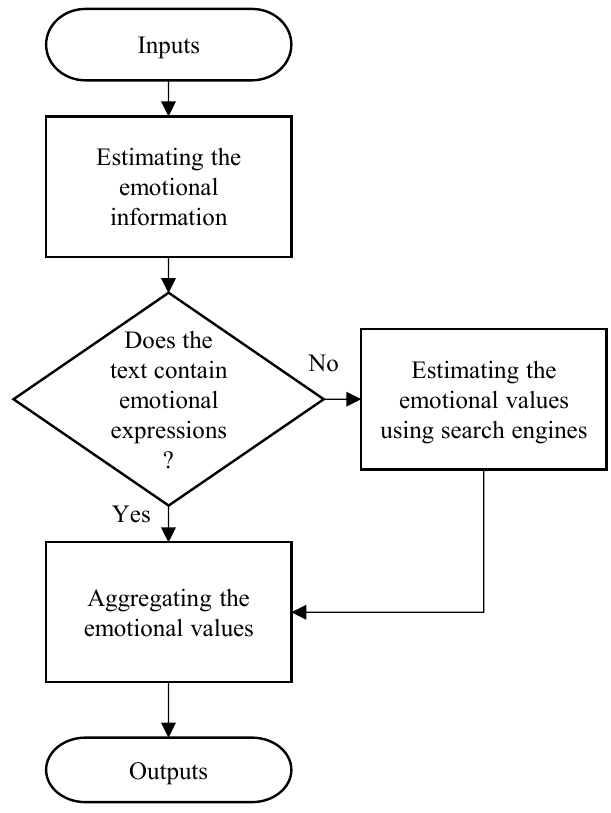
Figure 1. The flowchart of the system for classifying lyrics emotions.